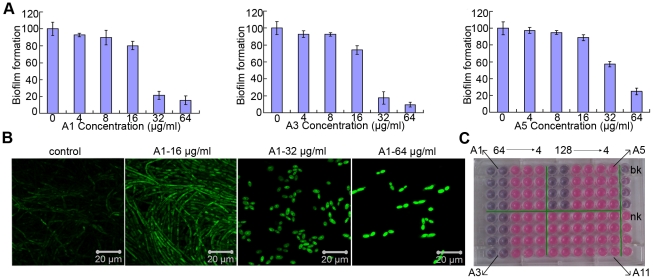
Biofilm formed of BWP17-DPP3-GFP cells pretreated with bisbibenzyls compounds.A) Quantitative measurement of inhibition of biofilm formation with Microplate Reader. B) Confocal micrographs of BWP17-DPP3-GFP cells cultured in RPMI 1640 for 48 hours. C) Cells were stained with alamar blue and cultured for 4–6 hours in dark, the supernatant would become pink when cells grow into biofilm, otherwise turn into blue. The test was performed in quadruplicate. A11 represents the compounds that biofilm inhibitory activity >64 µg/ml, bk represents blank control and nk represents negative control.